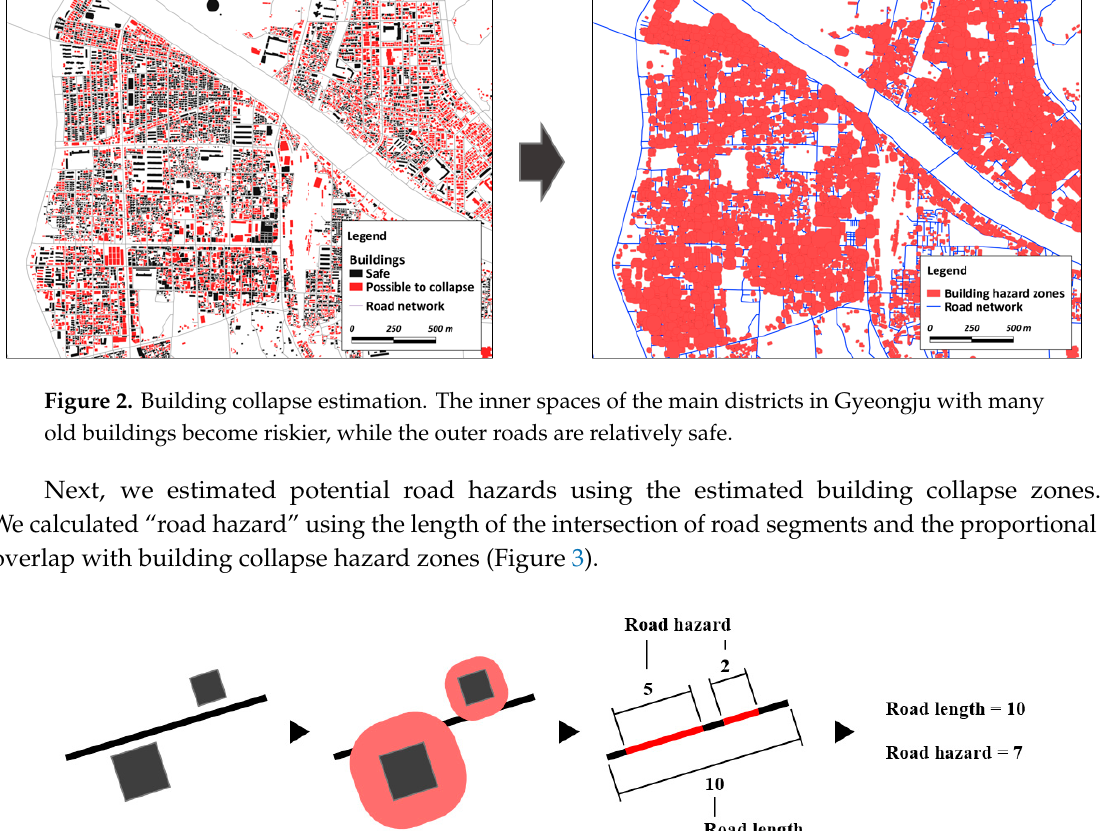
Figure 3. Road hazard analysis.